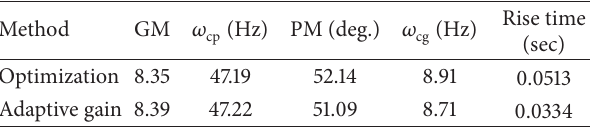
Table 6: Gain/phase margins, phase/gain crossover frequencies, and rise times. Method